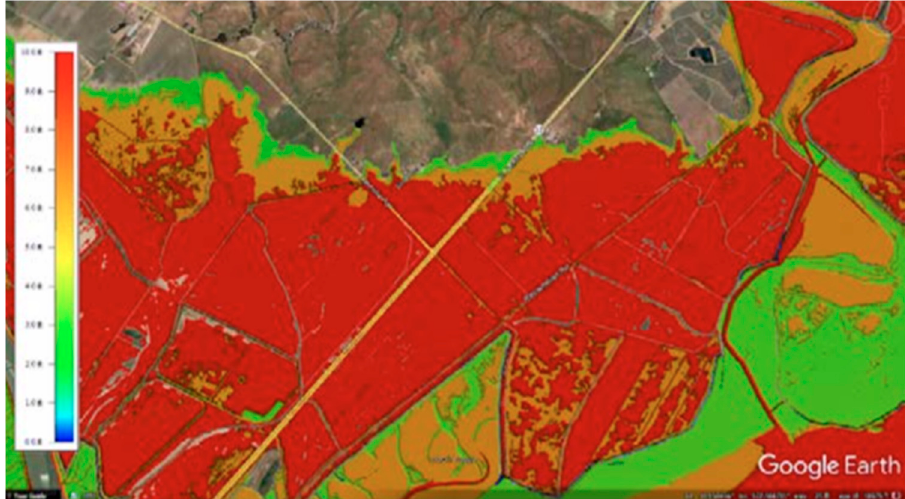
Figure 13. Visualization of flood potential over Highway 37 that was available for participants to explore during the TTE.